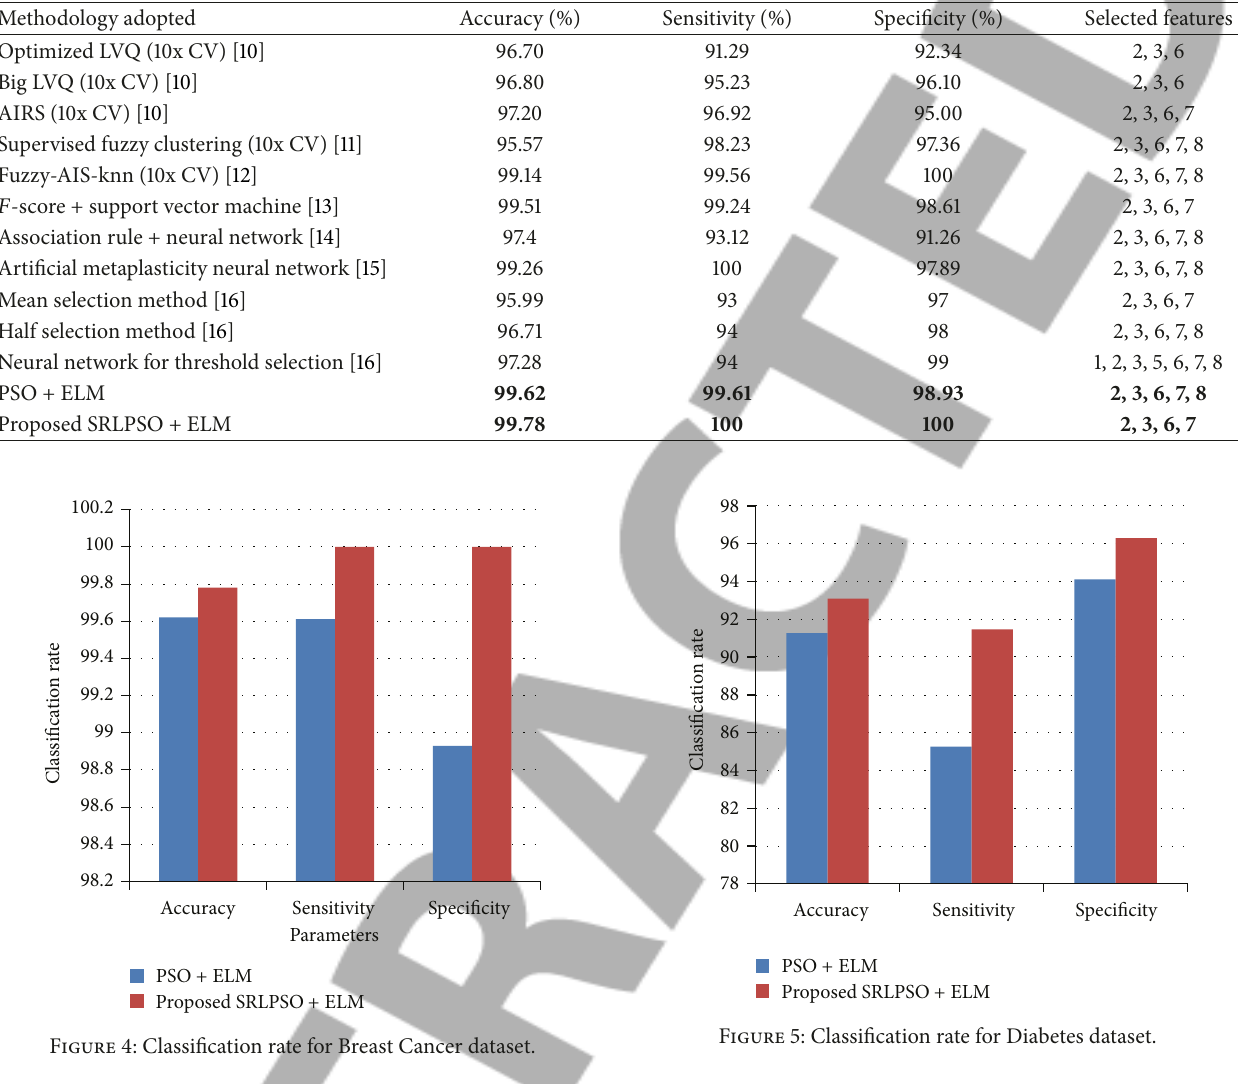
Table 3: Classification results with Breast Cancer dataset.